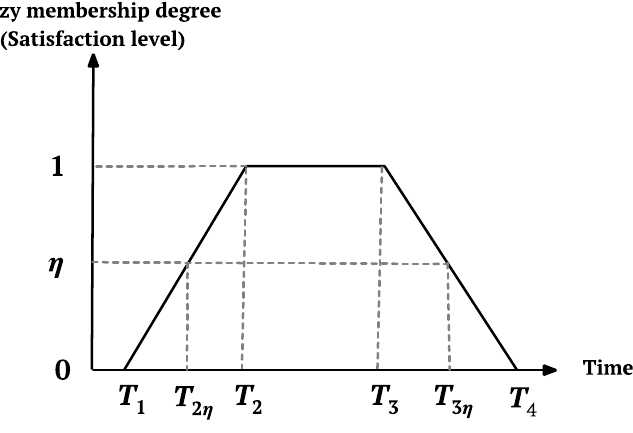
Figure 6. A fuzzy soft time window.